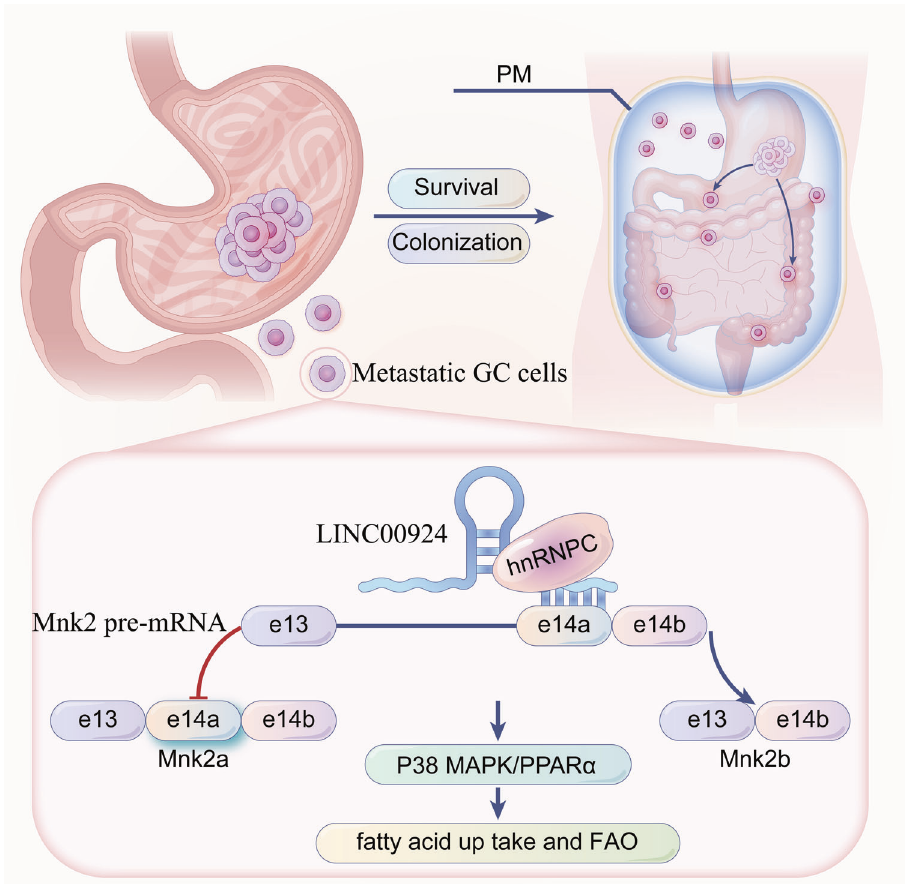
Fig. 8 LINC00924-induced fatty acid metabolic reprogramming facilitates gastric cancer peritoneal metastasis via hnRNPC-regulated alternative splicing of